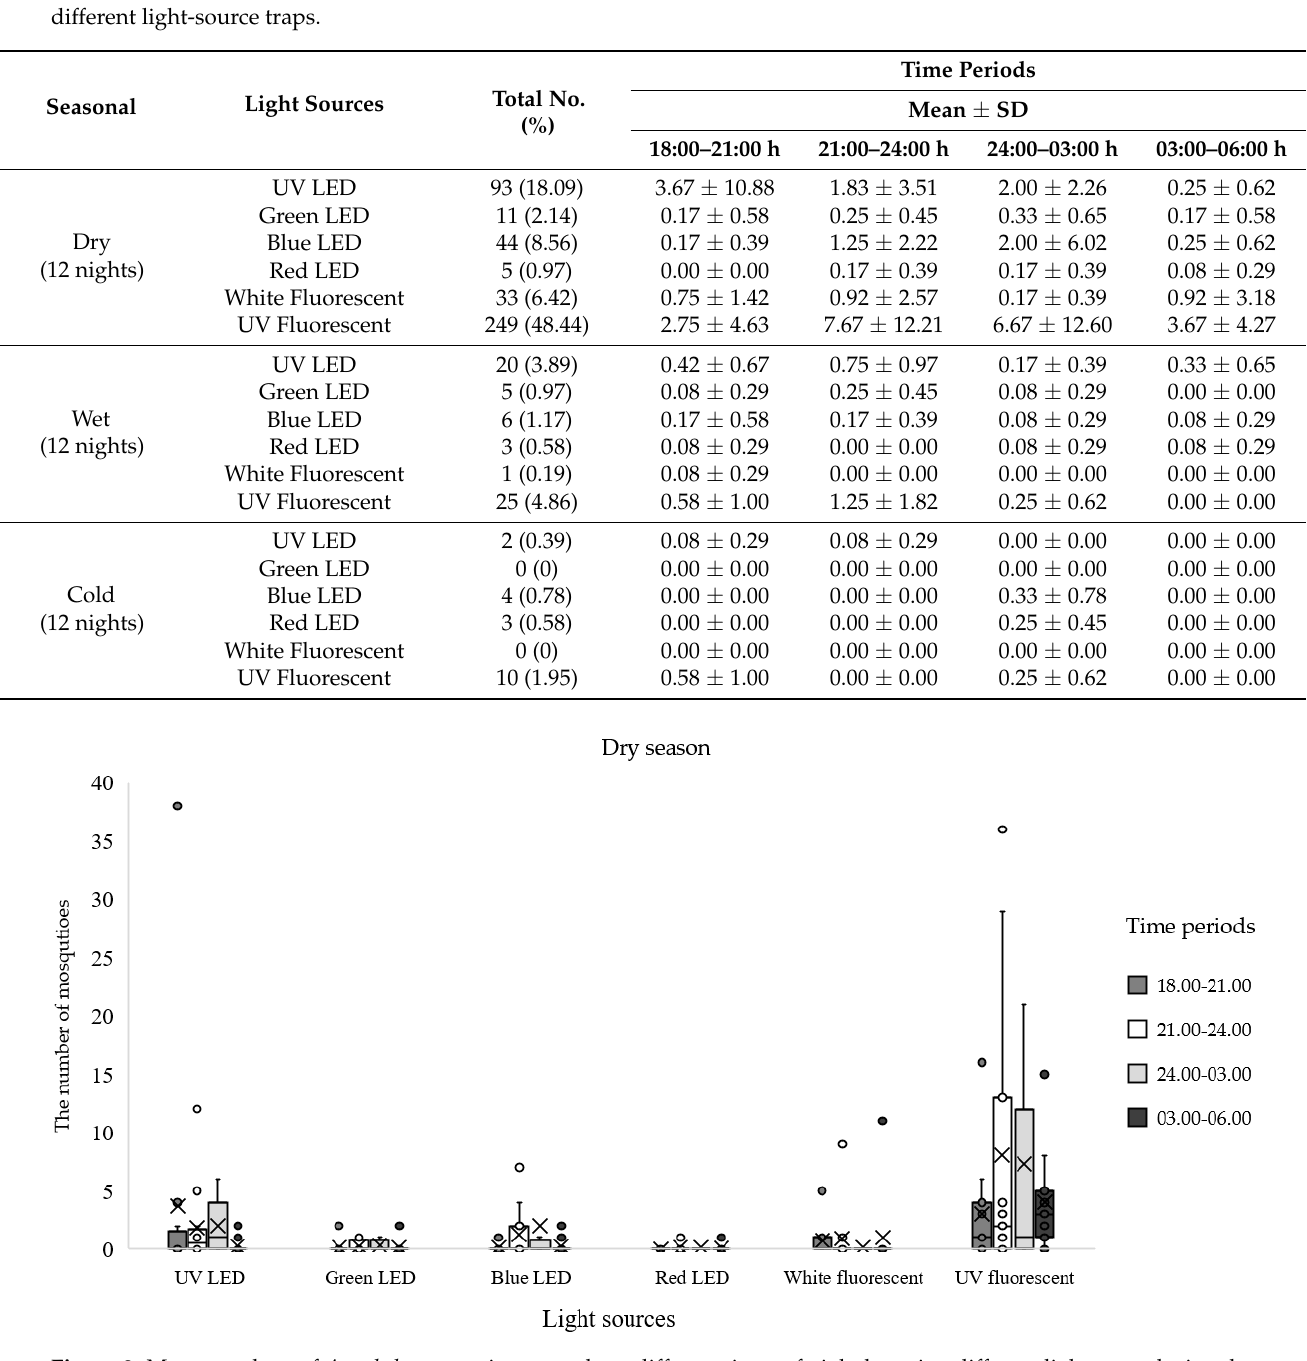
Figure 2. Mean numbers of Anopheles mosquitoes caught at different times of night by using different light traps during the dry season, February to May 2020.